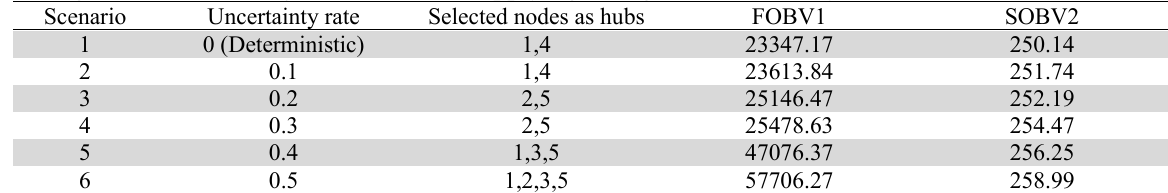
Fig. 7 . Changes in the value of the first and second objective functions by changing the capacity of the hubs Finally, in order to investigate the effect of the uncertainty rate in robust-box, the uncertainty rate from 0 to 0.5 is considered in 6 different scenarios. The value of the first and second objective functions derived from the certain and uncertain model is given in Table 7, below. Change the values of objective functions applying changes to uncertainty